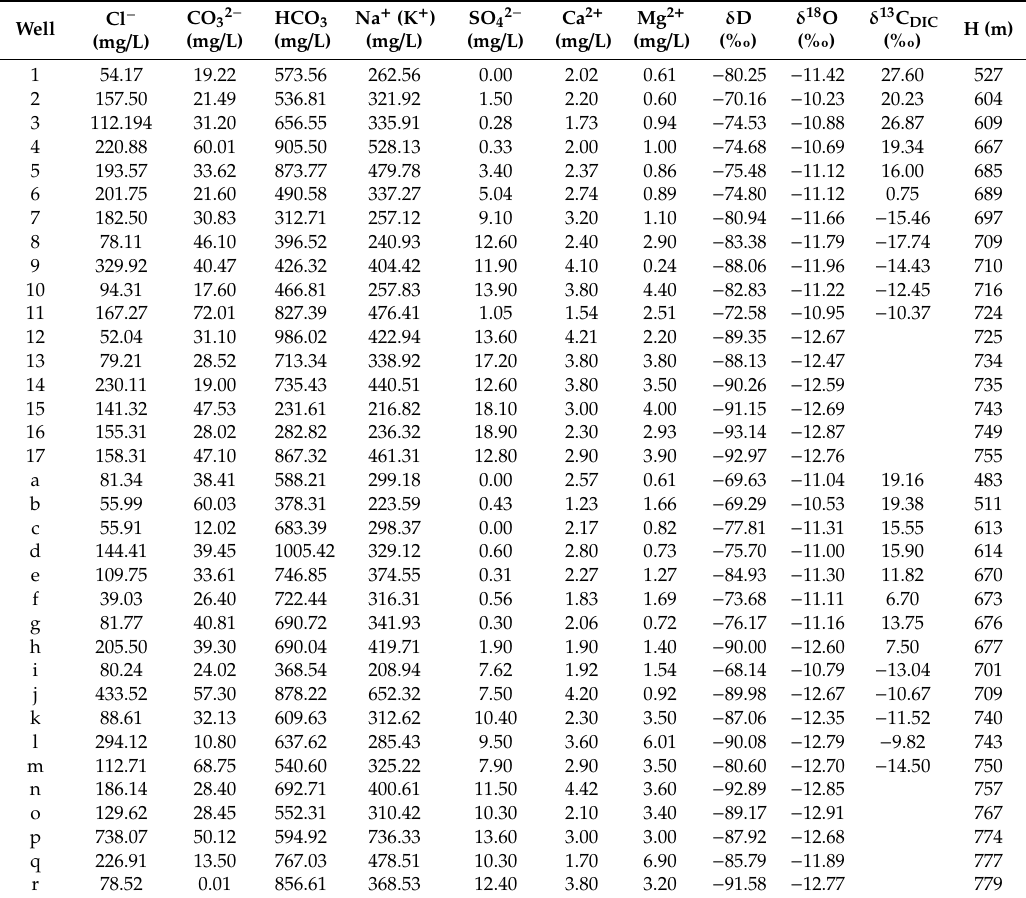
Table 1. Dissolved ions, isotopic results, and hydraulic head (H) of CBM co-produced water samples from the Shizhuangnan